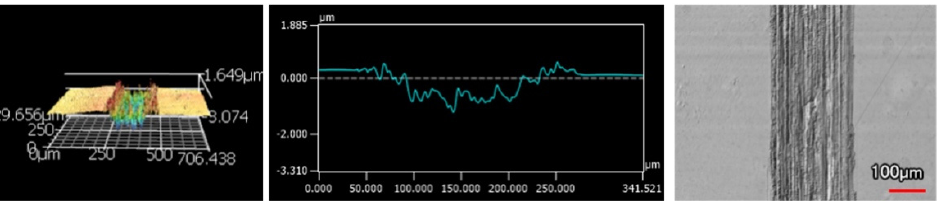
Figure 17. 9 μ m Thick Ni-P Coating 100 Passes of the Spherical Indenter.